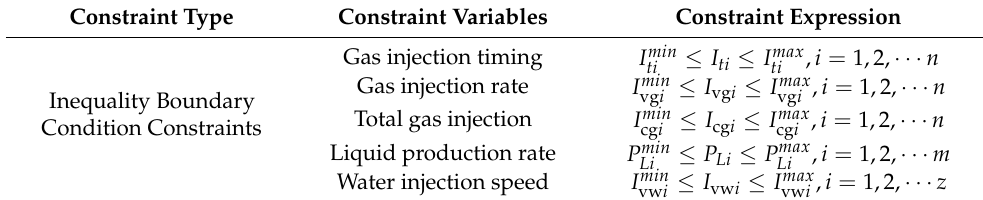
Table 5. Mathematical Model Constraints.